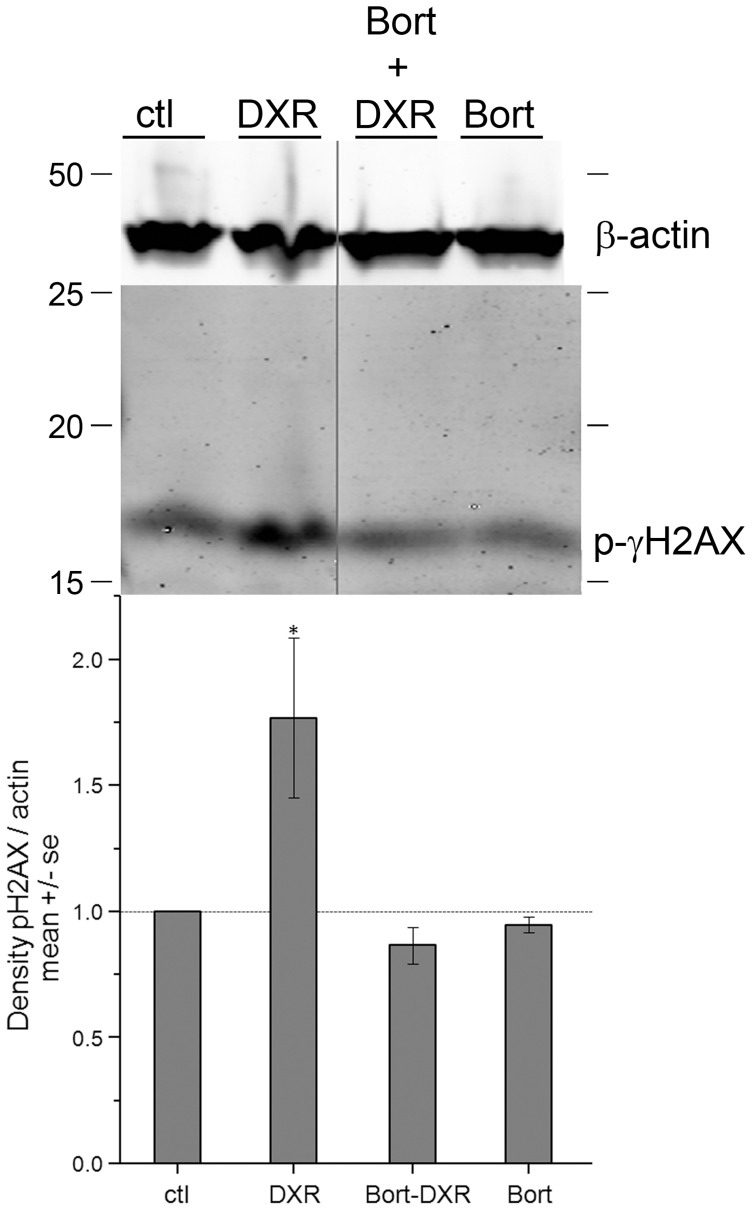
Western blot with corresponding quantification reveals DXR-induced changes in H2AFX phosphorylation were blocked by Bort pre-treatment.Blot probed with anti-phospho H2AFX antibodies revealed an increase in density of the corresponding 17 kDa band in ovarian lysates harvested 6 hrs post-DXR injection compared to ctl, which is absent in Bort-pretreated samples. *p<0.05, one-way ANOVA, Tukey means comparison. Blot shows β-actin as the loading control. N = 3 blots/quantification.